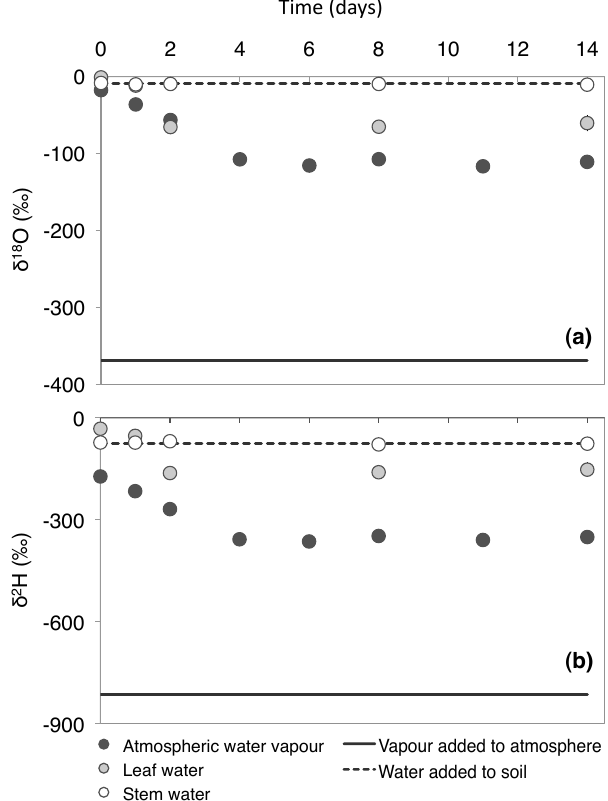
Figure 1. Temporal dynamics in the water isotopic signatures of the plant–soil–atmosphere system during continuous 2 H 18 (a) δ 18 O and (b) δ 2 H signature (in ‰) of the depleted water la- bel added as water vapour to the atmosphere (solid line), the water added to the soil (dashed line), the resulting water vapour in the chamber atmosphere (black circles) and the extracted leaf (grey cir- cles) and stem water (white circles). Error bars on the leaf water indicate ± 1 standard deviation of three plant